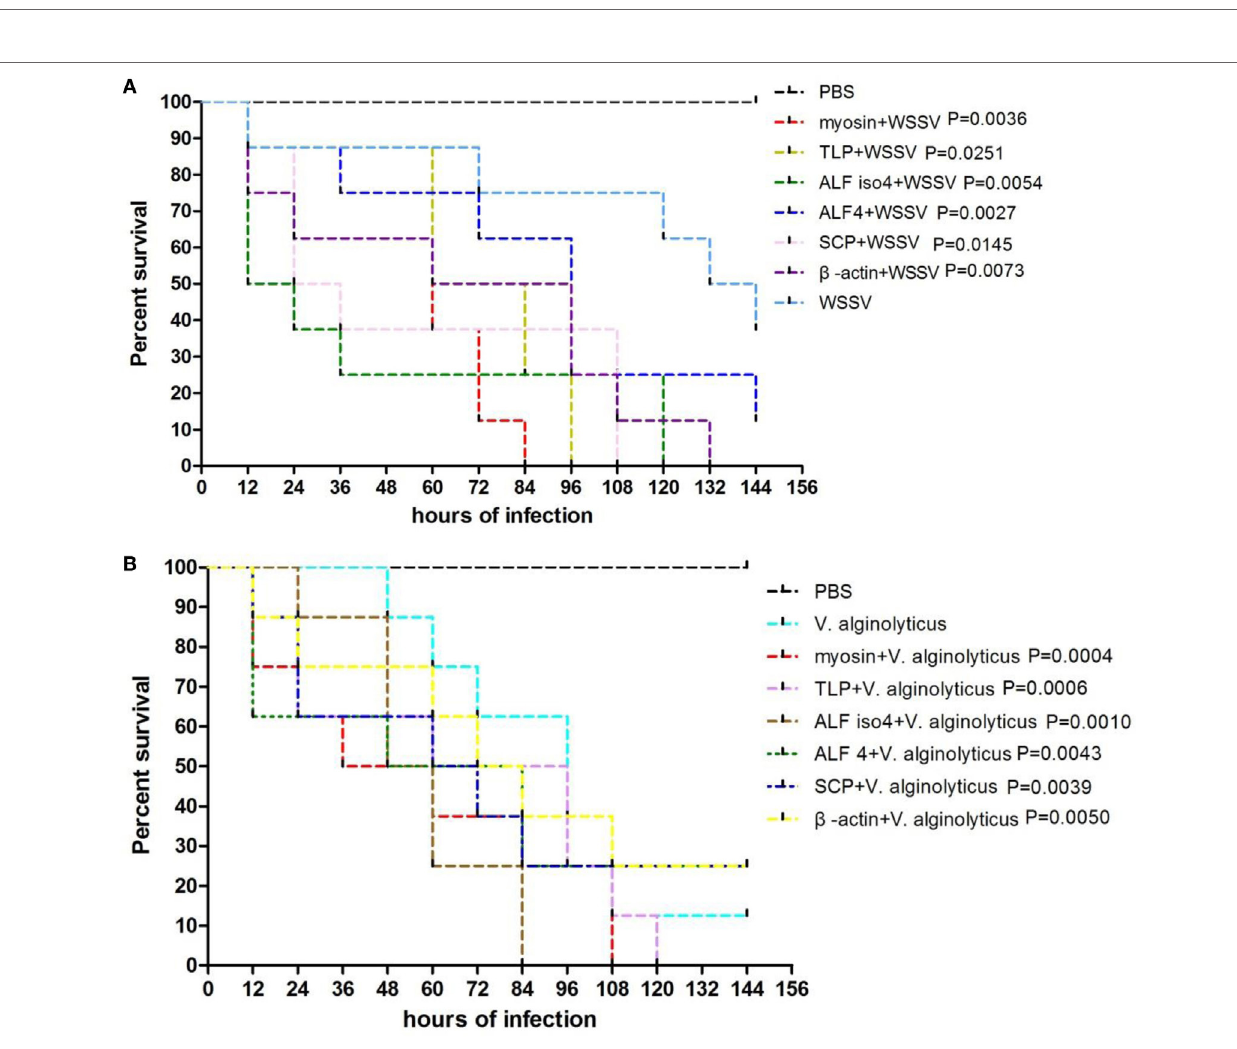
FigUre 7 | comparison of protective effects between six selected genes . The percentage survival of challenged crabs treated with dsRNA. Juvenile Scylla paramamosain were injected intramuscularly with dsRNAs 24 h before white spot syndrome virus (WSSV) challenge (a) or Vibrio alginolyticus challenge (B) . Control group was injected with phosphate-buffered saline (PBS) solution, and WSSV or V. alginolyticus group was challenged by WSSV or V. alginolyticus . The treatment is shown on the right. The P -value is the data of experimental groups compared to that of WSSV or V. alginolyticus